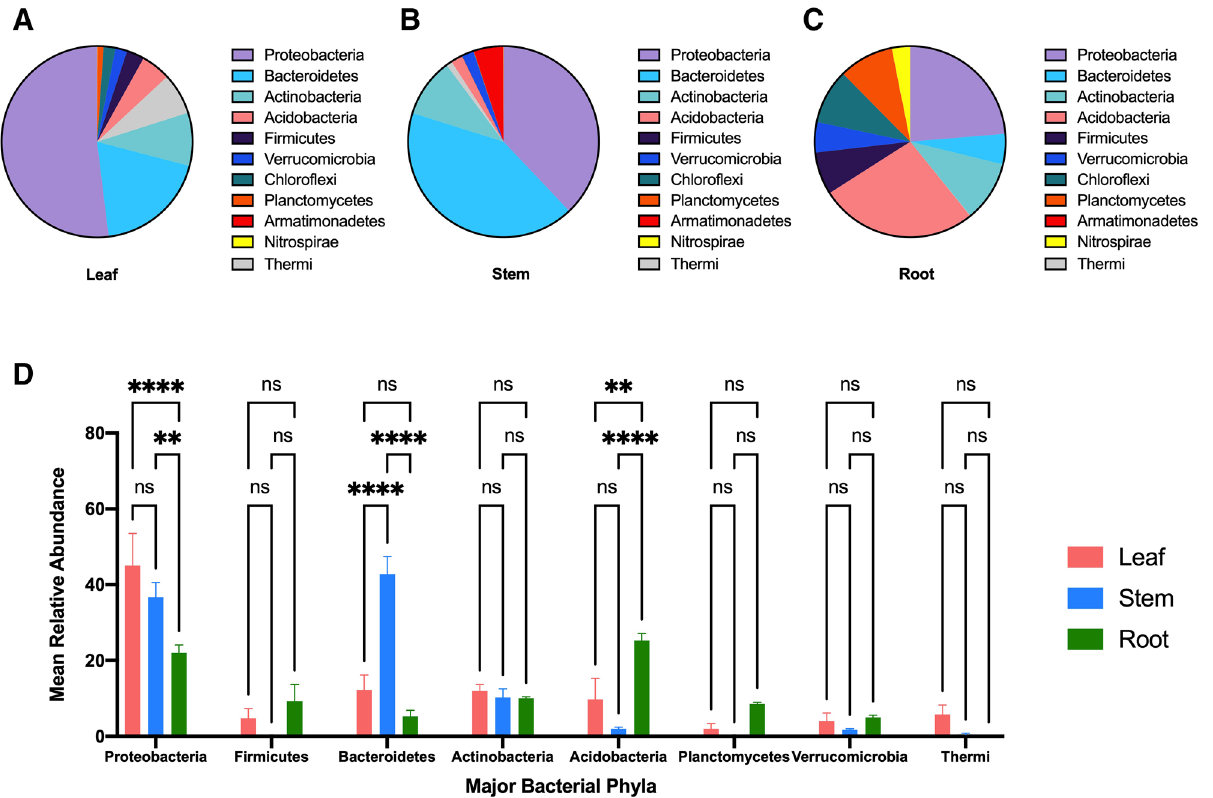
Figure 5. The most abundant bacterial phyla in Ginkgo biloba tissues ( A ) Leaf, ( B ) Stem, ( C ) Root. ( D ) The mean relative abundance of the most abundant phyla in Ginkgo biloba tissues . The mean relative abundance is shown as columns with Standard Error of Mean